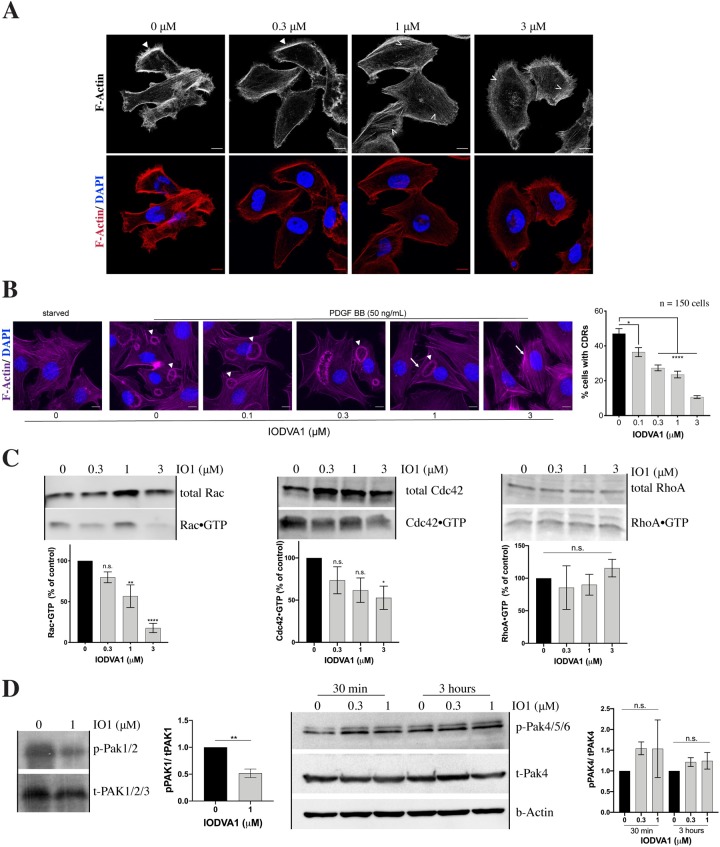
IODVA1 inhibits lamellipodia and circular dorsal ruffle (CDR) formation in MDA-MB-231 cells and decreases Rac activation.(A) IODVA1 inhibits EGF-induced lamellipodia formation in MDA-MB-231 cells. MDA-MB-231 cells were plated on fibronectin-coated coverslips, serum starved for 4 h, incubated with the indicated concentrations of IODVA1 for 1 h, then EGF (50 ng/mL) stimulated, fixed and stained with Phalloidin Alexa Fluor 594 (F-Actin, pseudocolored red) and DAPI (nuclei, pseudocolored blue). Representative images show lamellipodia formation and enrichment of actin staining at the leading edge (white closed arrowheads) at 0 and 0.3 μM concentrations and lack of lamellipodia with rounded cell morphology at 1 and 3 μM. Note equally distributed phalloidin staining with presence of stress fibers in the cell body of the 1 and 3 μM treated-cells (white open arrowheads) indicative of stationary cells. Scale bar = 10 μm. Results are representative of three independent experiments. (B) IODVA1 inhibits PDGF-induced CDR formation in 3T3 fibroblasts. NIH-3T3 cells were plated on fibronectin-coated coverslips, serum starved for 4 h, incubated with the indicated concentrations of IODVA1 for 1 h, then PDGF (50 ng/mL) stimulated, fixed and stained with Phalloidin Alexa Fluor 594 (F-Actin, pseudocolored magenta) and DAPI (nuclei, pseudocolored blue). Closed white arrowheads indicate circular dorsal ruffles, arrows indicate lack of elongated morphology typical in stimulated fibroblasts. The percentage of cells with CDRs was counted as the number of cells with CDRs normalized to the total number of cells in the field. Around 150 cells were counted per condition per experiment. Cells with multiple CDRs were counted only once. Results are representative of three independent experiments. Scale bar = 10 μm. (C) MDA-MB-231 cells were incubated with IODVA1 (IO1) at the indicated concentrations for 1 h, lysed, and incubated with GST-PAK-GBD (binds active Rac and Cdc42) and GST-Rhotekin RBD (binds active RhoA). The protein complexes were resolved on SDS-PAGE and immunoblotted with pan-Rac, Cdc42 or RhoA antibodies. Levels of active Rac (RacGTP, % of control), active Cdc42 (Cdc42GTP, % of control) and active RhoA (RhoAGTP, % of control) were quantified using ImageJ and ImageLab and show combined data as mean ± s.e.m. from at least 3 independent experiments. (D) Left panel—MDA-MB-231 cells were incubated with IODVA1 (IO1, 1 μM) for 30 min, lysed, and immunoblotted for pPAK1(T423)/ pPAK2(T402). Lysates were loaded in two replicates. Results shown are mean ± s.e.m. of two independent experiments. Right panel–MDA-MB-231 cells were incubated with IODVA1 (IO1, 0.3 and 1 μM) for 30 min or 3 hours, lysed and immunoblotted for pPAK4(S474)/ pPAK5(S602)/ PAK6(S560). Results shown are mean ± s.e.m. of two independent experiments. n.s.–not significant, *—p < 0.05, **—p < 0.01, ****—p < 0.0001.